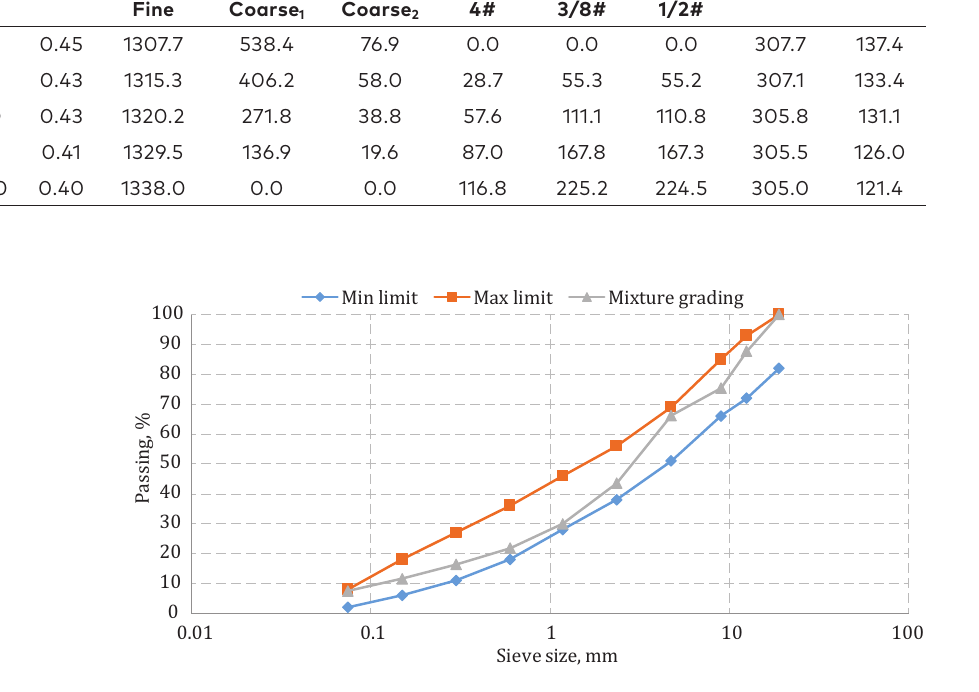
Figure 1. Blended aggregate gradation and allowable limits based on ACI